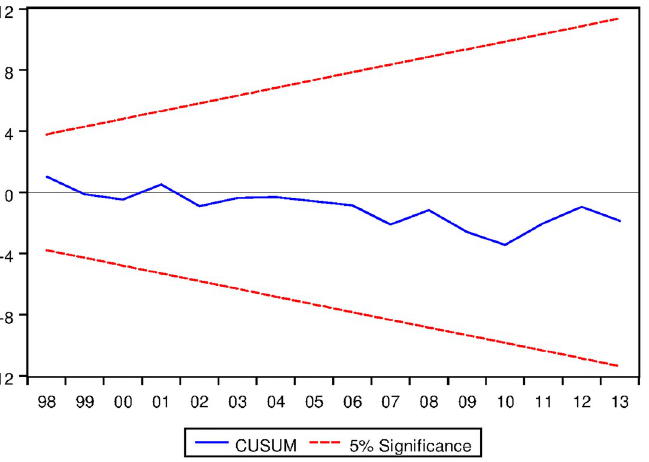
Fig 15. Stability diagnostic of cointegrating relationship for Australian data with constand fixed regressor under proposed framework.